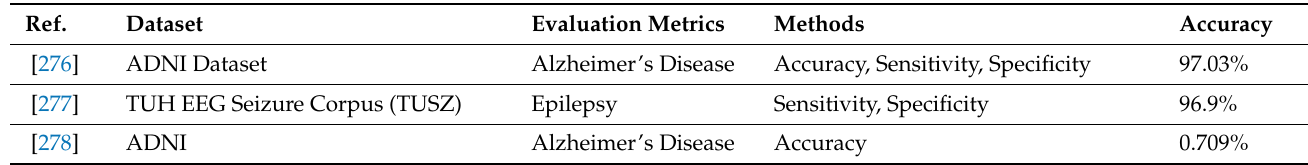
Table 18. GRU classifier result analysis on various NDs.